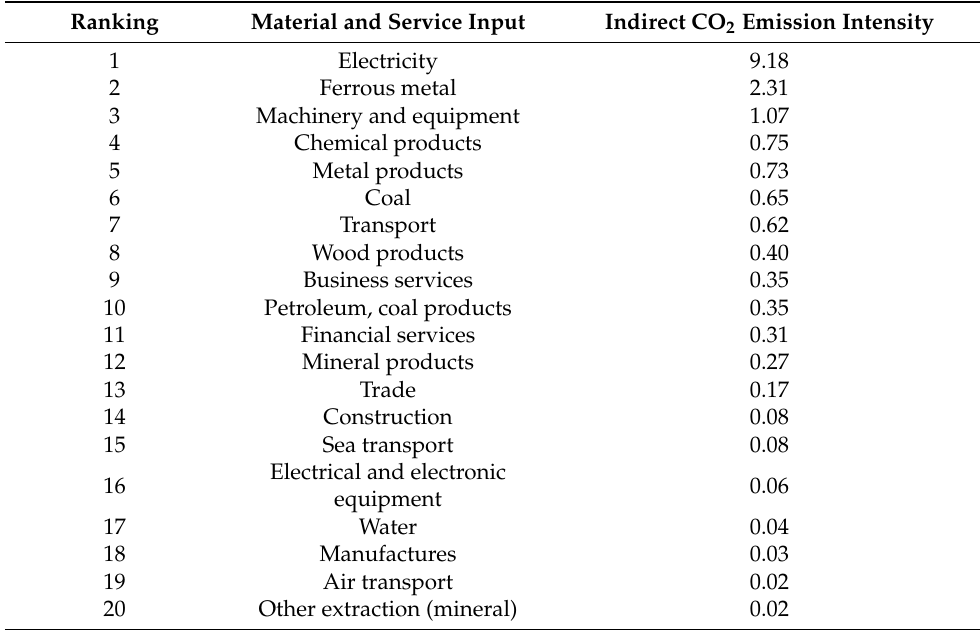
Table 1. Distribution of indirect CO 2 emission intensity of China’s coal production in 2014.